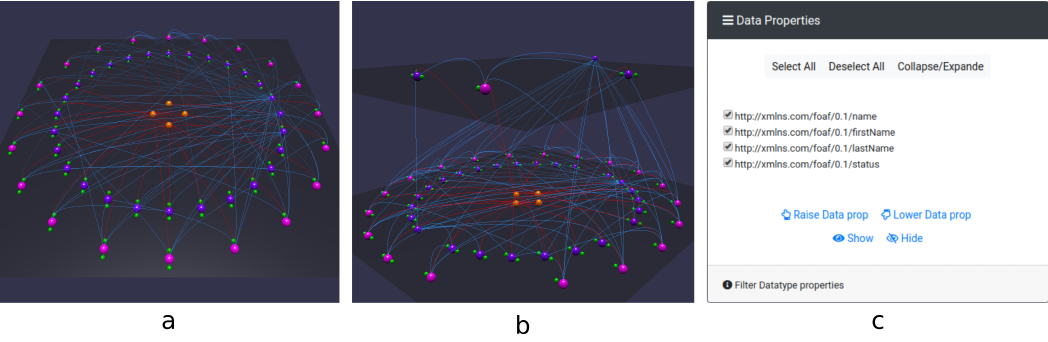
Figure 4. Filtering helps to gradually build the desired visualization of data: an example knowledge base ( a ); the result of filtering ( b ); and one of the UI boxes through which filtering can be applied ( c